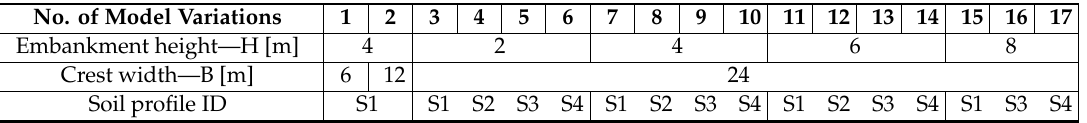
Table 2. Geometry variations.